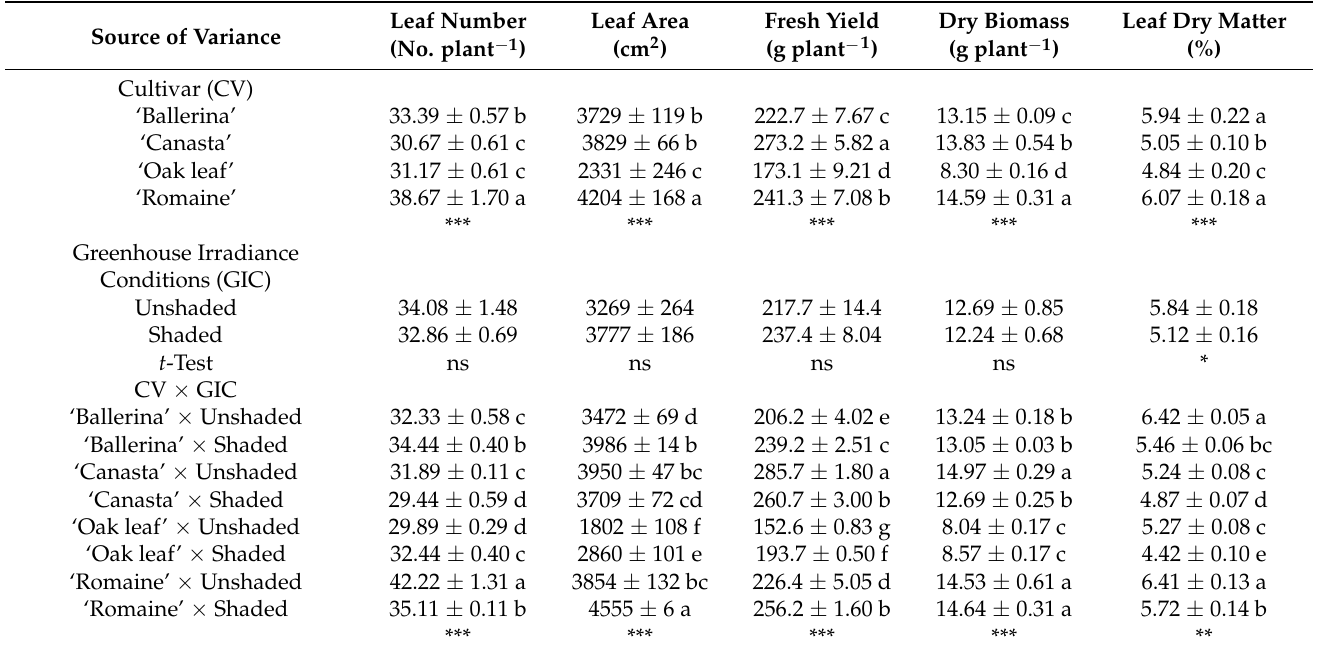
Data are mean values ± standard error, n = 3. Mean comparisons were performed by Duncan’s Multiple Range Test (DMRT) for CV and by t -Test for GIC. Different letters within columns indicate significant mean differences compared by DMRT ( p = 0.05). ns, *, **, and *** denote nonsignificant or significant effects at p ≤ 0.05, 0.01, and 0.001,